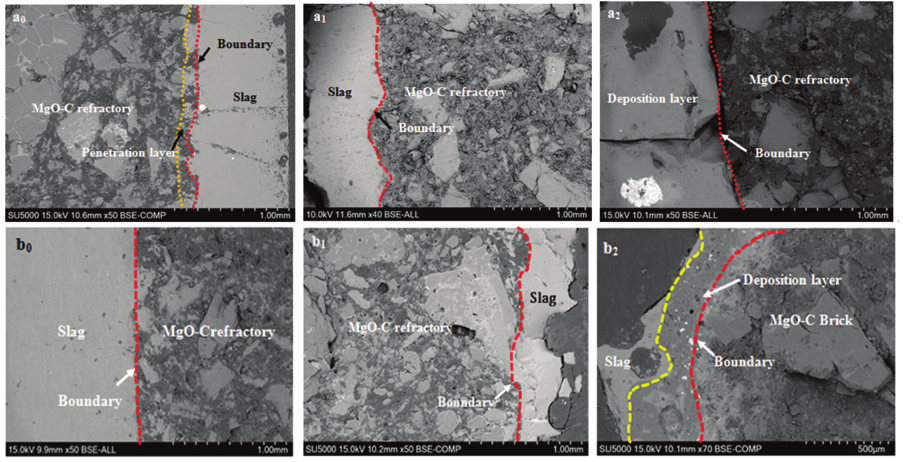
Figure 5: Interfacial structure of MgO-C refractory corroded in different slag components (a-No.1 and b-No.2) (the subscript 0, 1 and 2 represent reference sample, anode and cathode, respectively)